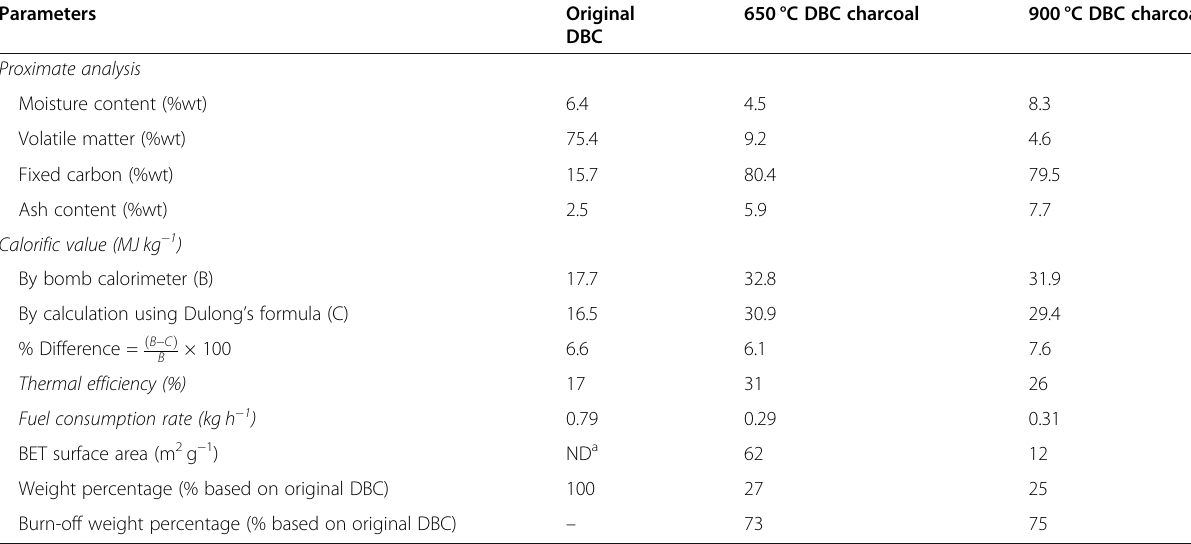
Table 1 Physical characteristics of the test samples